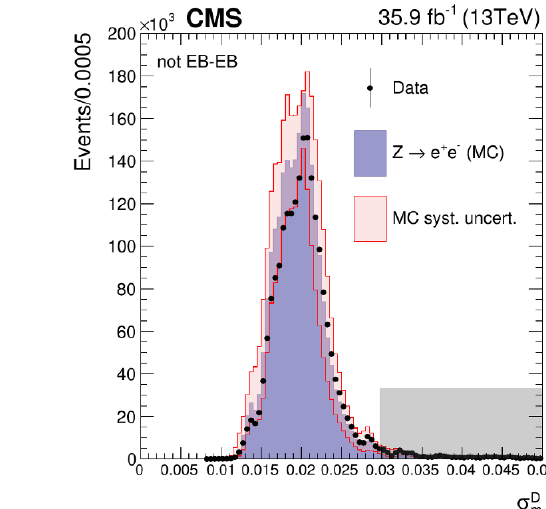
distributions in data and m